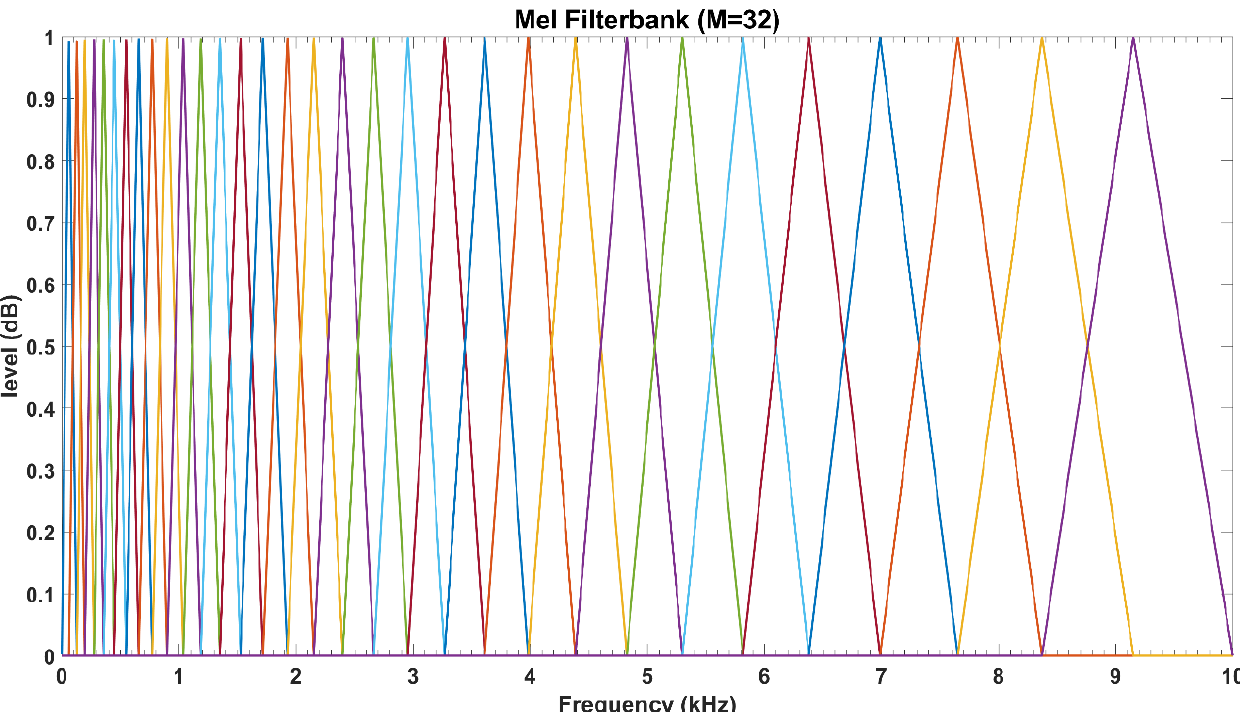
Figure 3. Block diagram of GFCCs feature extraction module.